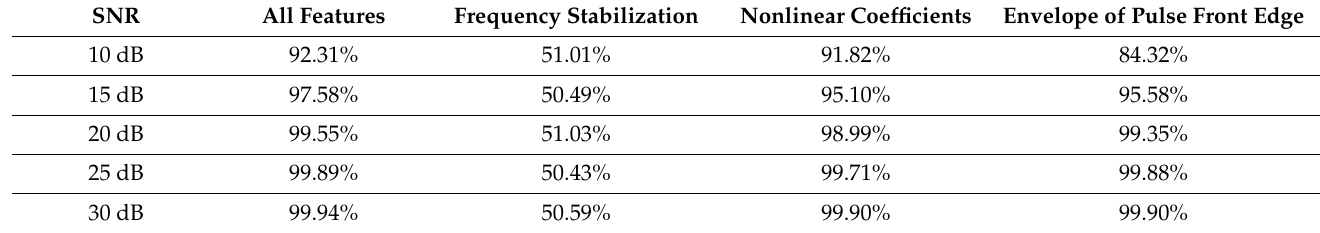
Table 3. Accuracy with various features.